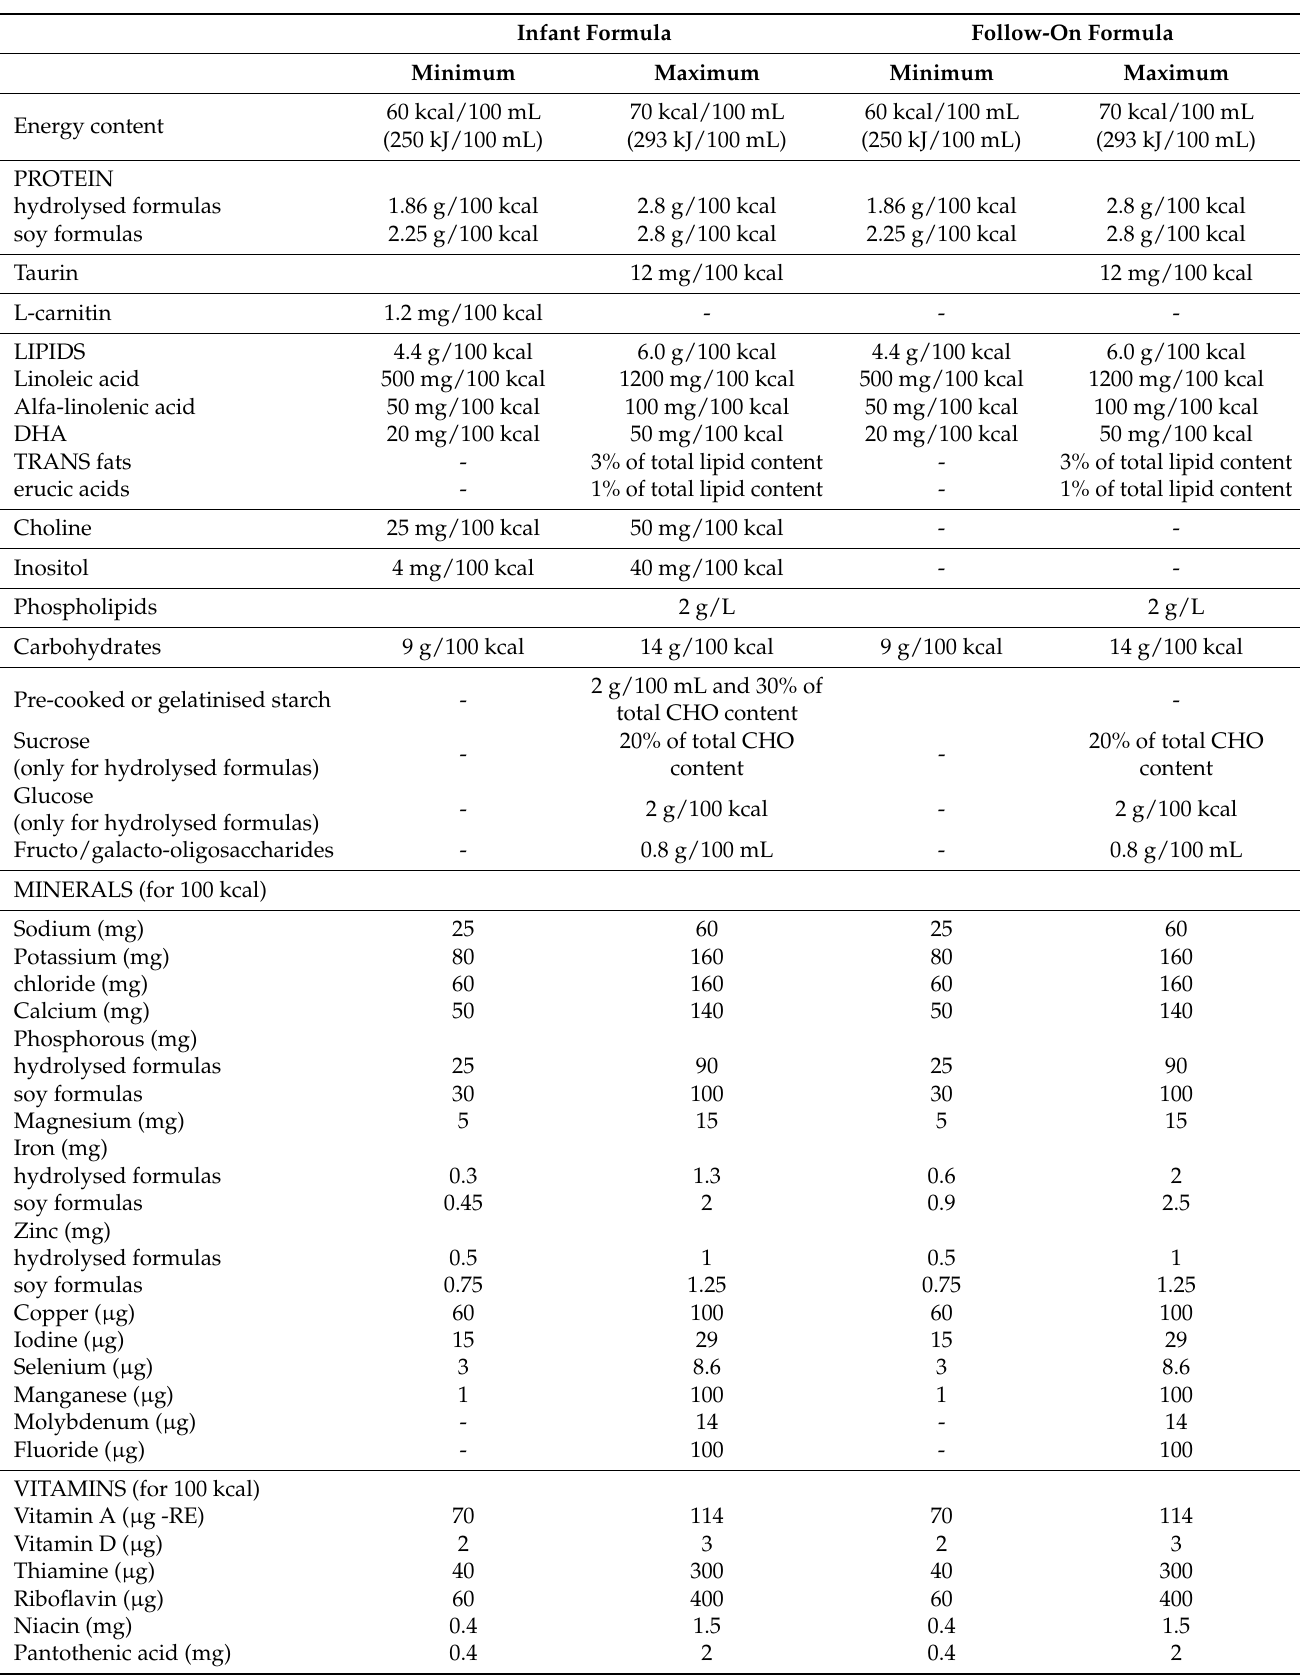
Table 1. Nutrient composition of hydrolysed and soy formulas during infancy and the follow-on